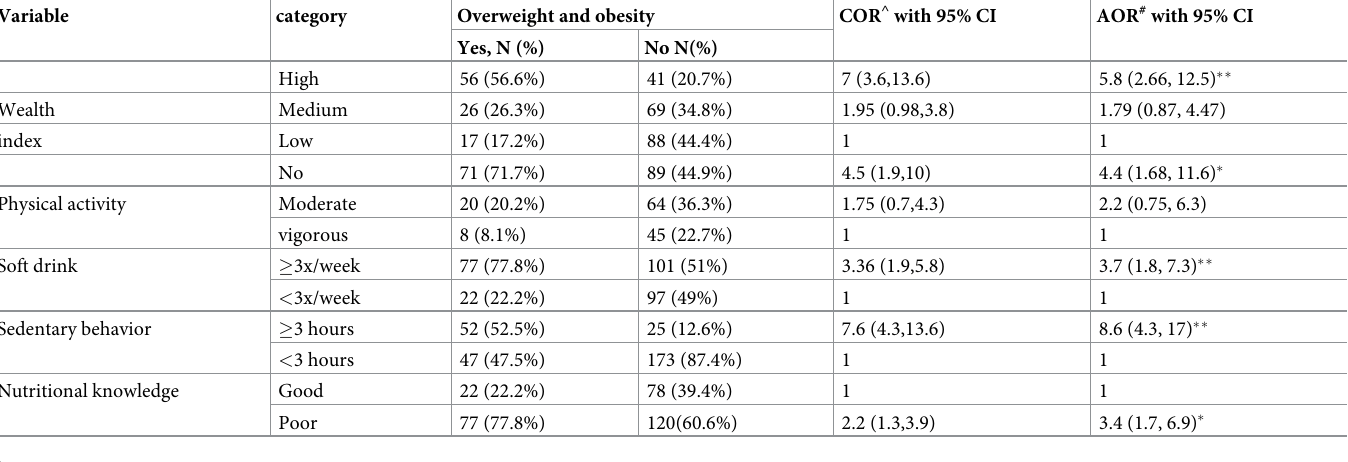
Table 4. Multivariable logistic regression analysis of factors associated with overweight/obesity among school adolescents in Butajira Town Southern Ethiopia, 2019.